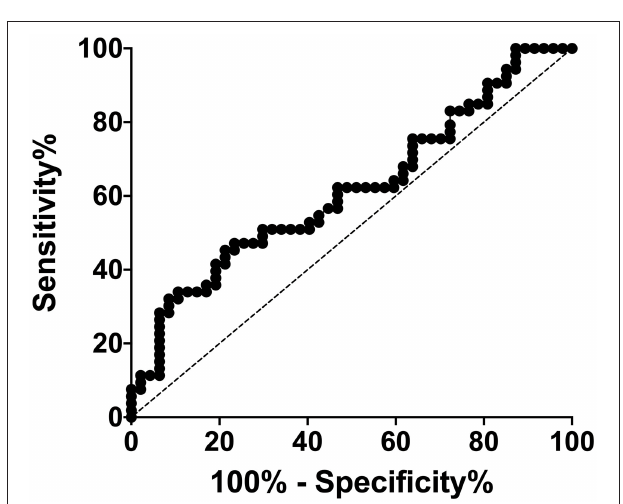
FIGURE 2 | Receiver-operating characteristic curve of